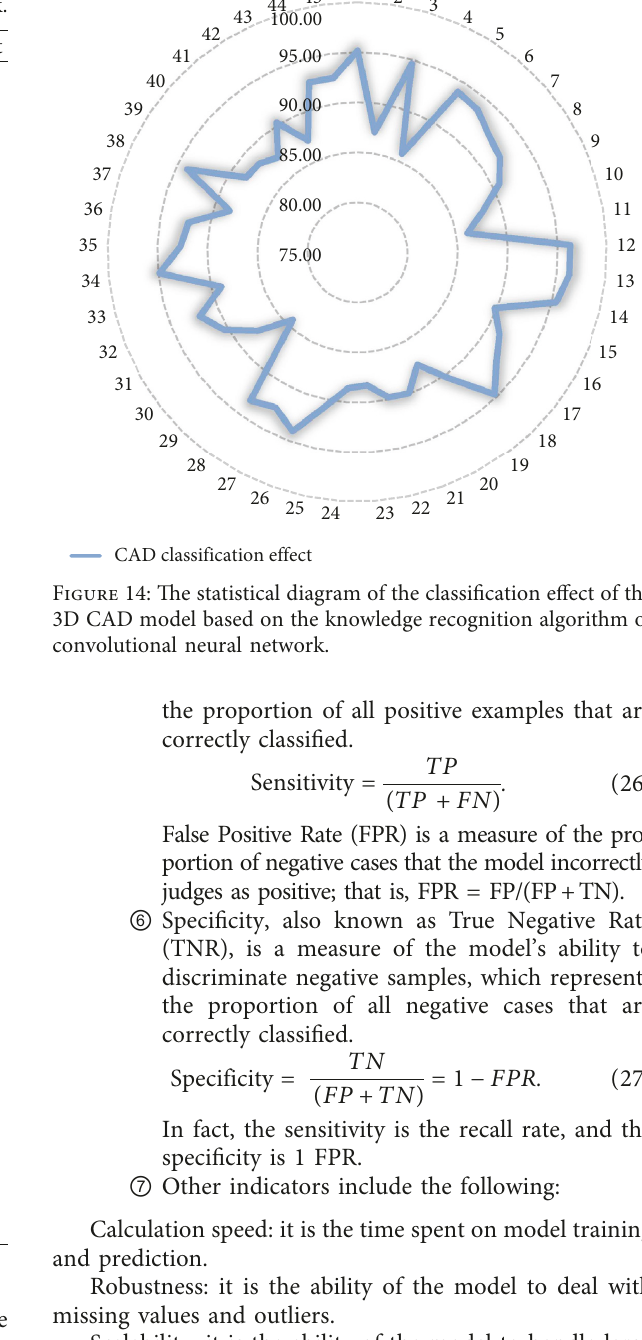
Table 2: Classification effect of 3D CAD model based on knowledge recognition algorithm of convolutional neural network.